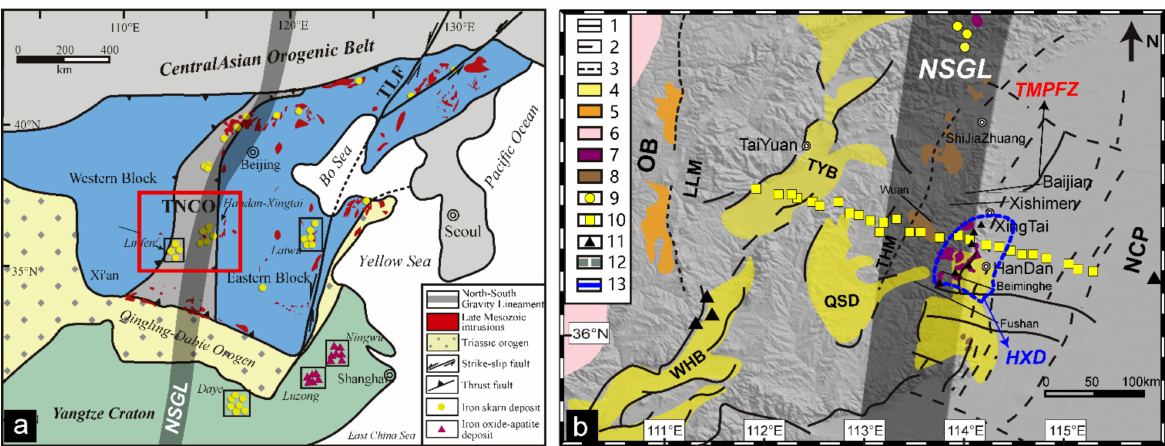
Figure 1. ( a ) A simplified map of the North China Craton and adjacent regions showing the distri- bution of late Mesozoic granitoid intrusions and major districts hosting large iron-skarn and iron oxide-apatite deposits (modified from [9,10]; ( b ) Geological sketch map of the research area (modified from [10–14]), showing the distribution of dioritic and monzonitic intrusions related nonferrous metal deposits. Most Fe deposits occur near the Taihang Mountains. MT site locations of the profile used in this study are also shown.1—fault; 2—buried fault; 3—basement liniment;